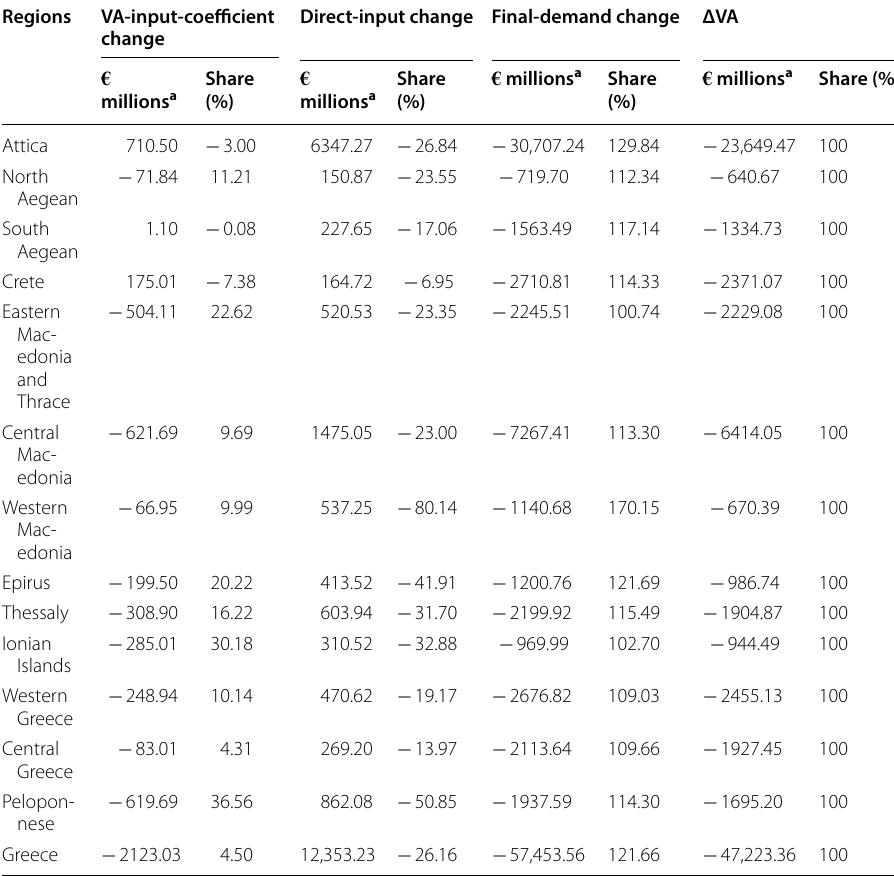
Table 4 Driving forces of regional income: Greece, 2010–2013. Source: Calculations by the authors